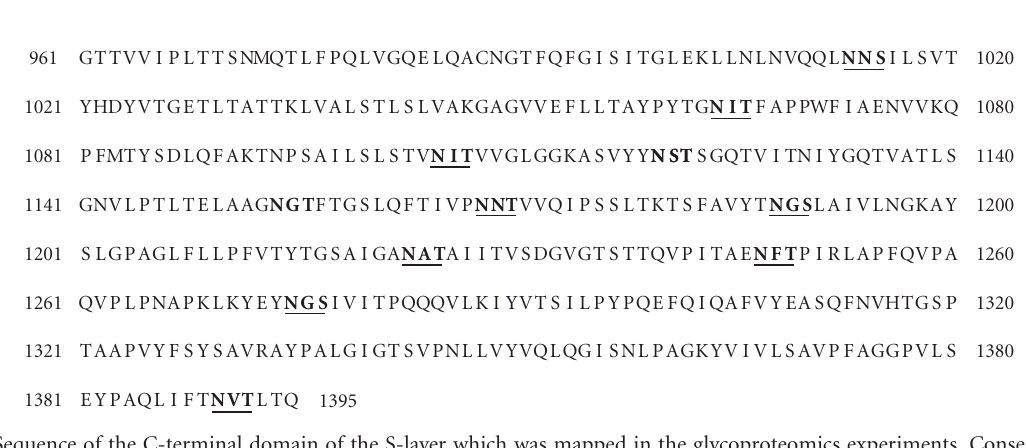
Figure 7: Sequence of the C-terminal domain of the S-layer which was mapped in the glycoproteomics experiments. Consensus sites (in bold) which were shown to be glycosylated are